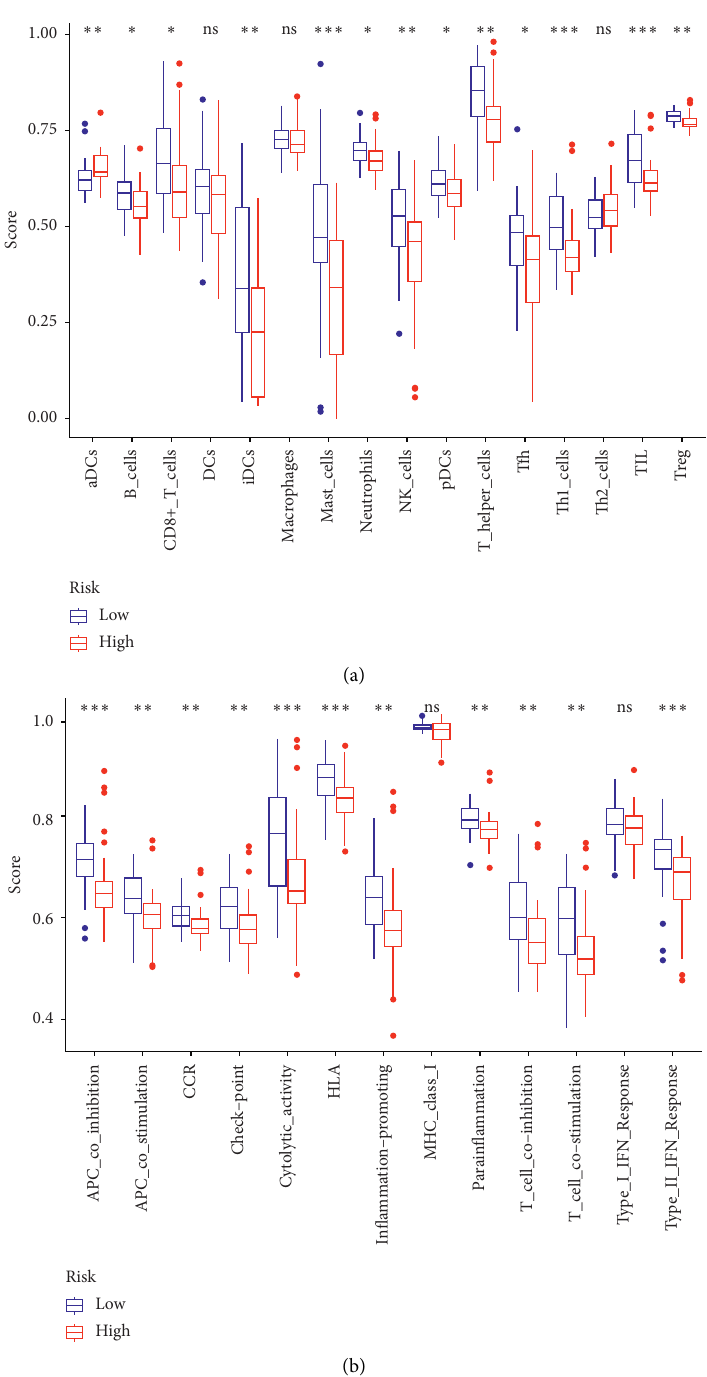
Figure 7: The ssGSEA scores of two groups in TCGA. (a) Scores of 16 immune cells. (b) Scores of 13 immune-related